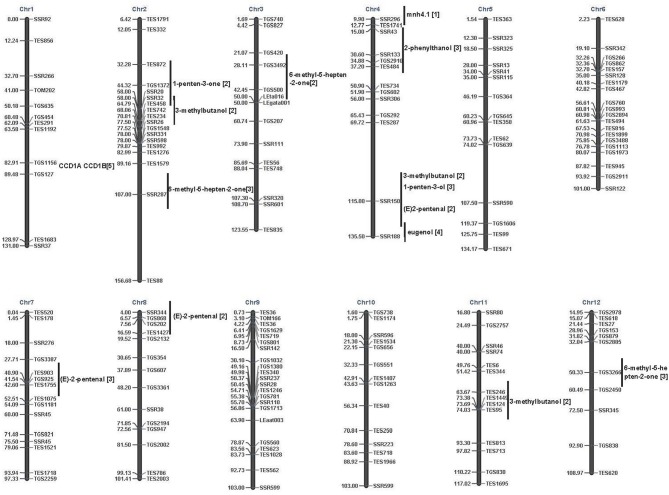
Comparison of associations and QTLs identified by linkage mapping. Horizontal line corresponds to the genetic location of associated marker (right) and the associated volatiles (left). Vertical line is the approximate regions of the identified QTLs. QTLs identified by Saliba-Colombani et al. (2001) were indicated by [1] to the end of volatiles; QTLs identified by Tieman et al. (2006) were indicated by adding [2] to the end of volatiles; QTLs identified by Mathieu et al. (2008) were indicated by [3] to the end of volatiles; QTLs identified by Zanor et al. (2009) were indicated by [4] to the end of volatiles. CCD, carotenoid cleavage dioxygenases. CCD1A and CCD1B are two genes from the tomato genome data and were indicated by [5] to the end of genes. In Simkin et al. (2004), these two genes were listed as LeCCD1A and LeCCD1B.